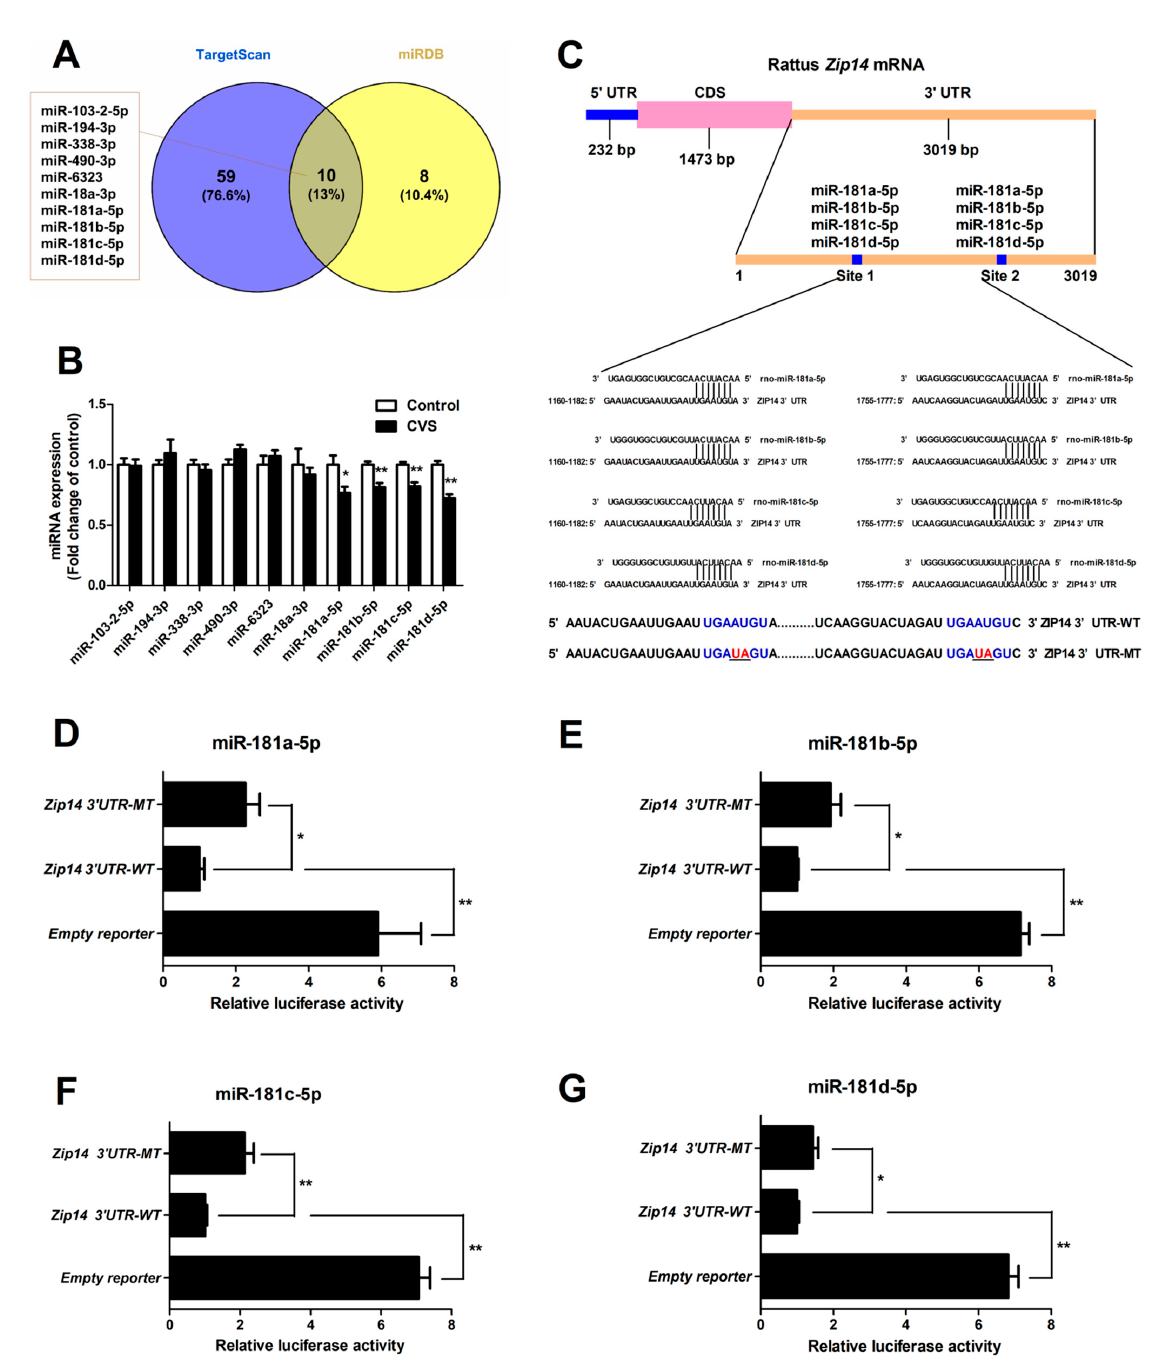
Figure 5. miR-181 family members directly target the 3 (cid:48) UTR of Zip14 . ( A ) Venn diagrams showing 10 overlapping miRNAs identified by TargetScan and miRDB. ( B ) Expression levels of candidate Zip14 gene 3 (cid:48) UTR-targeting miRNAs were analyzed by qRT-PCR. ( C ) Schematic description of conserved binding sites for miR-181 in Zip14 mRNA and sequence of the wild-type and mutated miR-181 binding site. ( D – G ) Relative luciferase activities of wild-type and mutated Zip14 3 (cid:48) UTR reporter plasmid in HEK-293T cells cotransfected with an miR-181 overexpressing plasmid for 24 h. Values were expressed as means ± SEM, n = 6 in each group for panel B, n = 4 in each group for panels D-G. * p < 0.05, ** p <